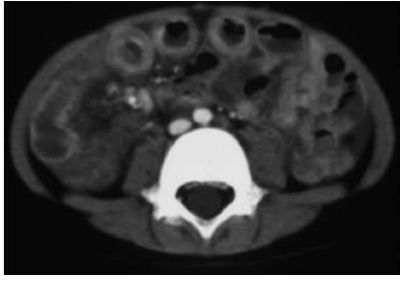
Figure 1. On abdominal computerized tomography, diffuse wall thickening is noted in the small bowel and colon. A small amount of ascites is